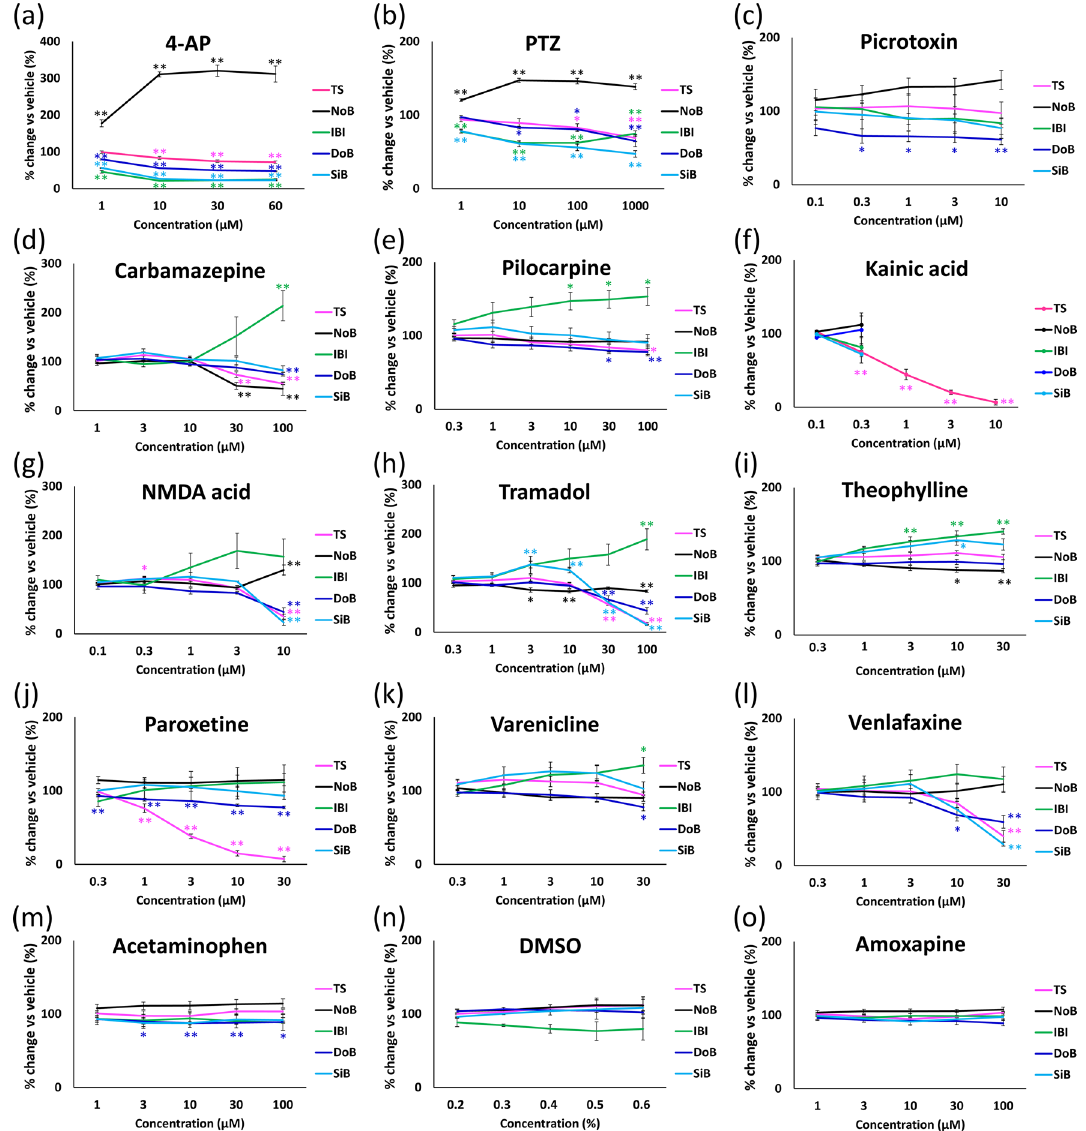
Figure 2. Concentration-dependent changes of 15 compounds in five parameters: TS (pink), NoB (black), IBI (green), DoB (blue), SiB (cyan). Parameters were depicted as the average % change of control (vehicle control set to 100%) ± SEM from n = 3–4 wells. Data were analyzed using one-way ANOVA followed by post hoc Dunnett’s test (*p < 0.05, **p < 0.01 vs.